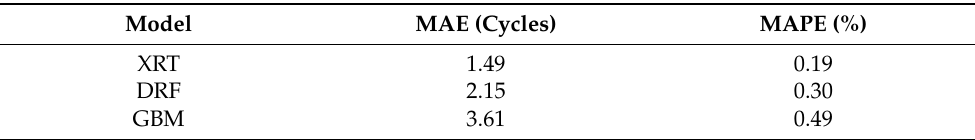
Table 2. Results for mean absolute error (MAE) and mean percentage error (MAPE) from default random forest (DRF), extremely randomized trees (XRT) and gradient boosting models (GBMs). The corresponding parameters were